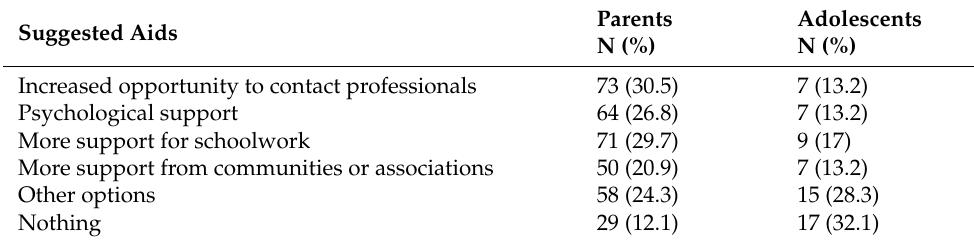
Table 7. Aids suggested during the lockdown.